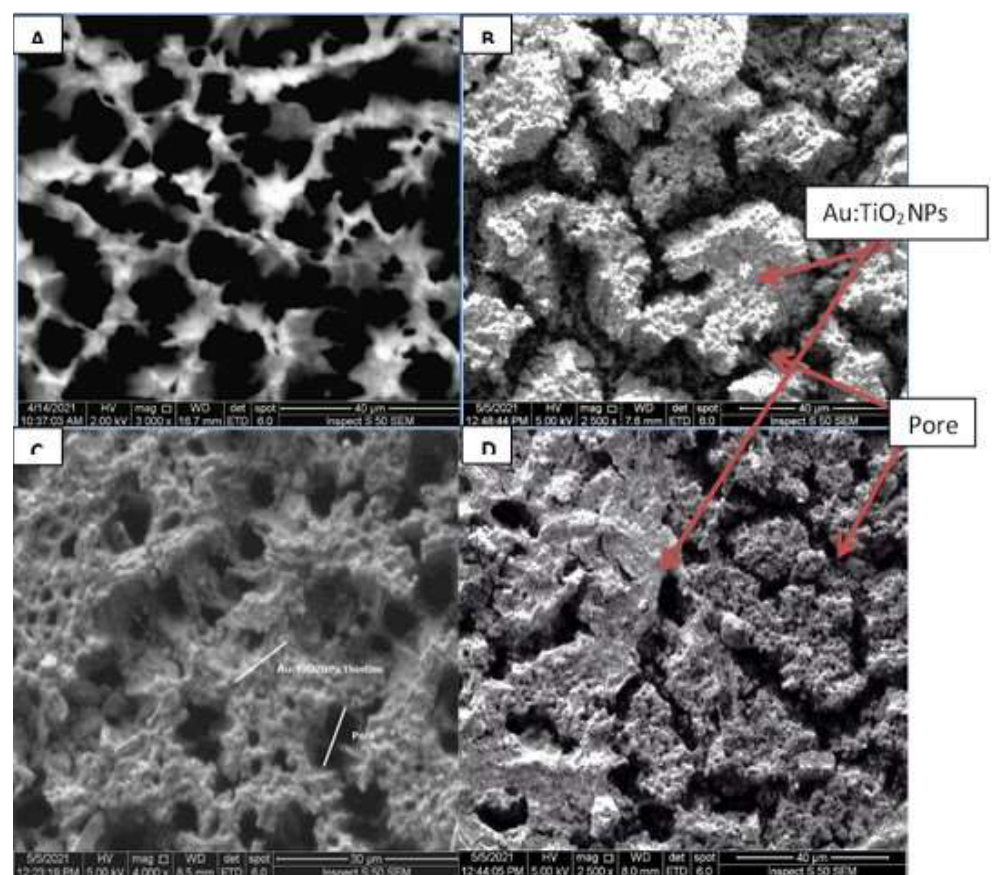
Figure 2: SEM images of Au:TiO 2 NPs/PS (A) PS(12mA/cm 2 ) (B) Au:TiO 2 NPs laser ablated at 600 mJ (C) Au:TiO 2 NPs laser ablated at 800 mJ (D) Au:TiO 2 NPs laser ablated at 1000